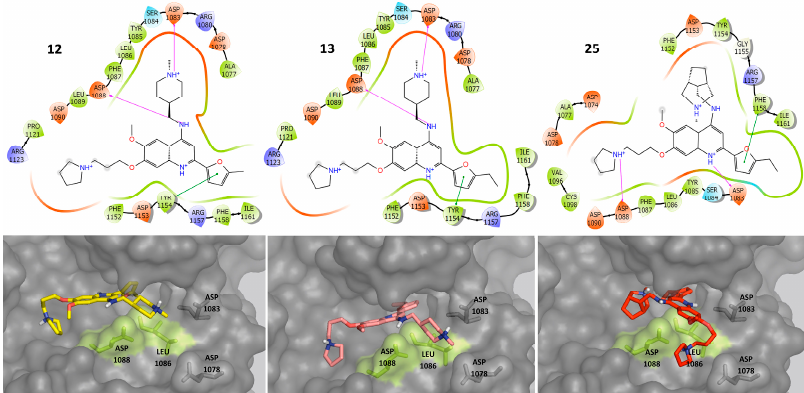
Figure 6. Predicted binding poses of dual compounds against G9a. Key amino acids proposed for the dual activity are highlighted in green.